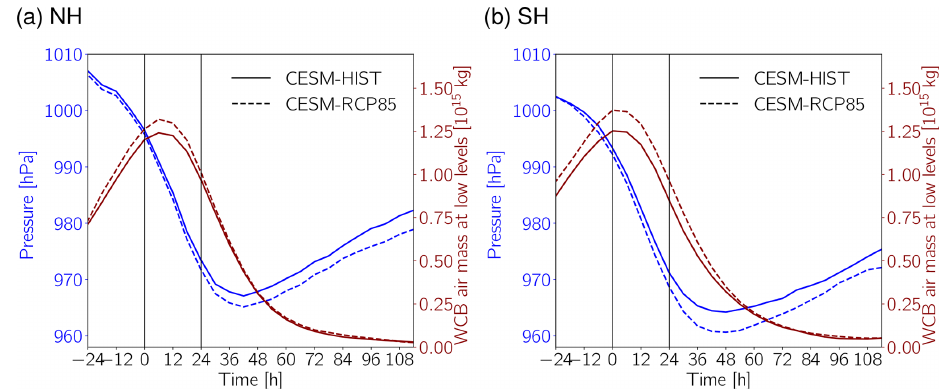
Figure 6. Mean time evolution of minimum SLP (hPa; blue) and the WCB air mass at p > 500hPa (red; 10 15 kg) along C1 cyclones in CESM-HIST (solid) and CESM-RCP85 (dashed) in the (a) NH and (b) SH. Times t = 0h and t = 24h correspond to the beginning and end of the 24h period of the strongest cyclone deepening. Table 3. Maximum values of the cyclonic low-level, cyclonic upper-level, and anticyclonic upper-level PV anomaly in C1 cyclones in NH winter in the middle ( t = 12h) and at the end ( t = 24h) of the 24h period of strongest deepening in CESM-HIST and CESM-RCP85 and the relative change between the two simulation periods. NH CESM-HIST CESM-RCP85 Relative change Cyclonic low-level PV anomaly at t = 12h 1.06pvu 1.33pvu + 25 . 5% Cyclonic low-level PV anomaly at t = 24h 1.31pvu 1.96pvu + 49 . 6% Cyclonic upper-level PV anomaly at t = 12h 2.17pvu 2.41pvu + 11 . 1% Cyclonic upper-level PV anomaly at t = 24h 2.36pvu 2.64pvu + 11 . 9% Anticyclonic upper-level PV anomaly at t = 12h − 2 . 10pvu − 2 . 39pvu − 13 . 8% Anticyclonic upper-level PV anomaly at t = 24h − 2 . 90pvu − 3 . 17pvu − 9 .